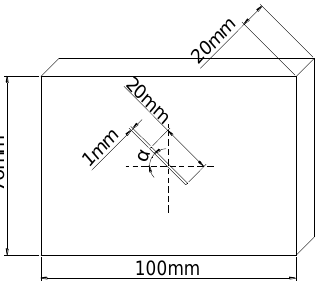
Figure 3. Schematic diagram of the crack inclination.